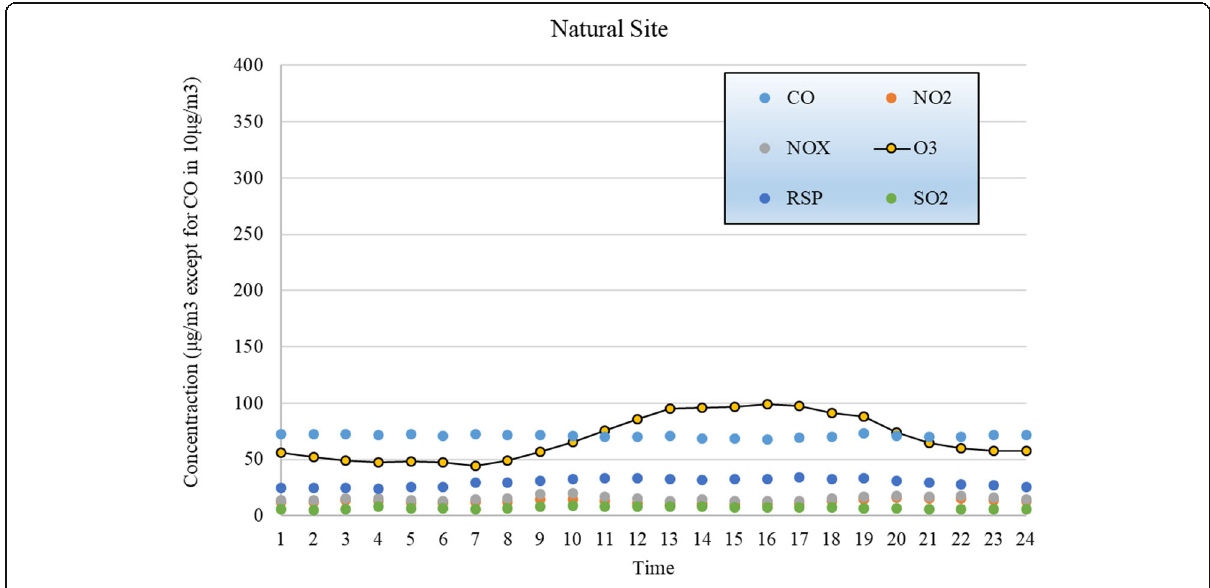
Fig. 6 Air quality parameters at a natural site (Tap Mun, Hong Kong)